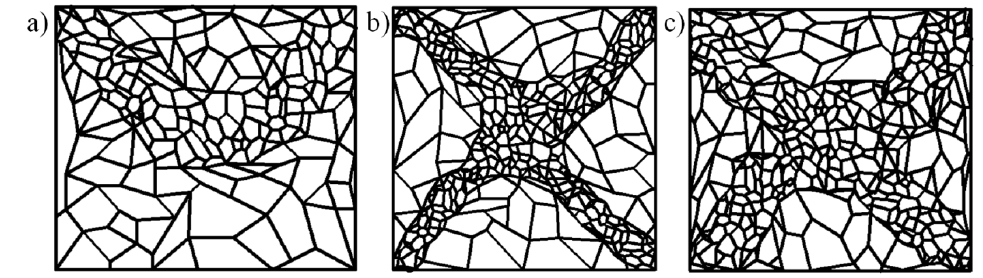
Figure 4. Internal grain size evolution of CMDF: ( a ) 3, ( b ) 6, ( c ) and 9 passes.